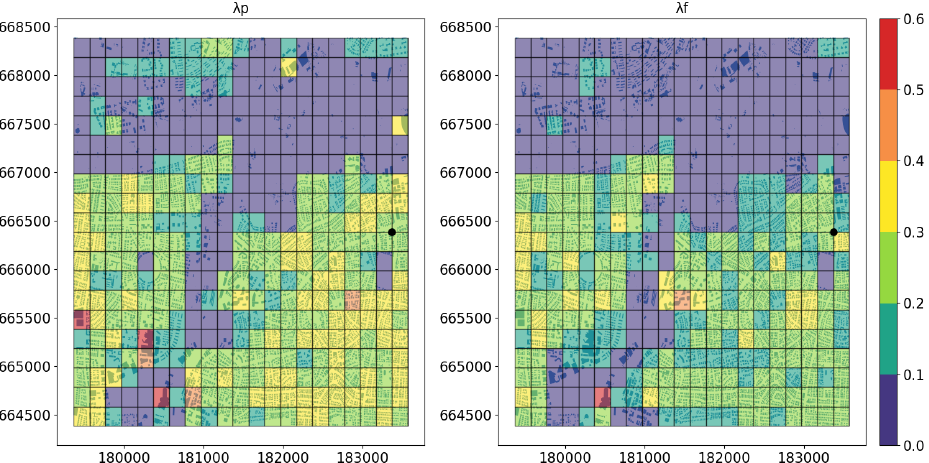
Figure 3. A map of all the buildings in the relevant part of Tel Aviv metropolitan area for the third case described in Table 2 is shown (black point represents the location of the POI in this case). The grid (200 m × 200 m) layer on top of this map, represents the average morphological parameters ( λ p ( left ) and λ f ( right )) as calculated in Equation (6) (Israeli Traverse Mercator (EPSG 2039) is used for this figure; The 6-digit coordinates are expressed in